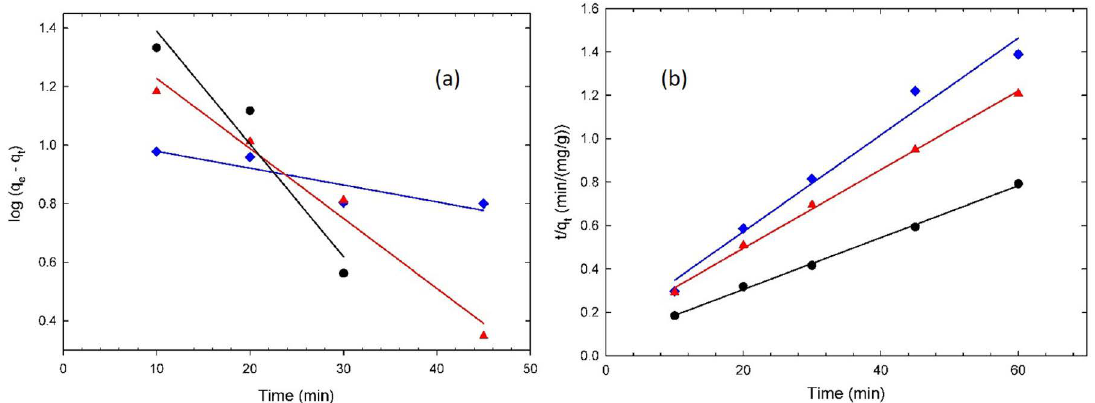
Figure 6. Pseudo (a) -first and (b) -second order plot for Pb(II) sorption onto HA. Table 1. Parameter values calculated using the pseudo-first and the pseudo-second order models for the adsorption of Pb(II) onto HA. Pb(II)